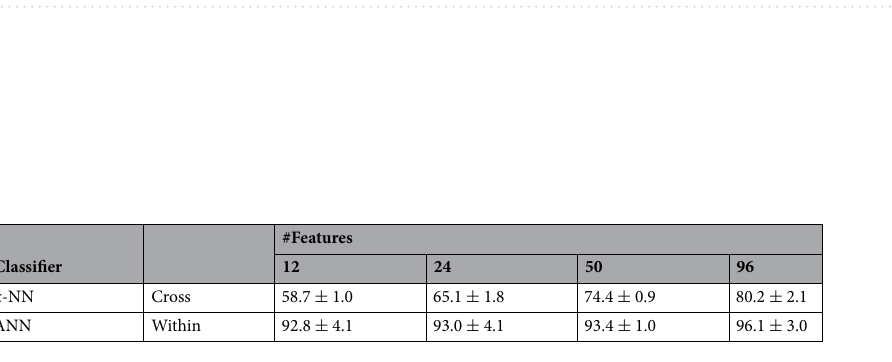
Table 6. Accuracies obtained for each subject in the within-subject experiments when a FB-CSP pipeline is adopted.